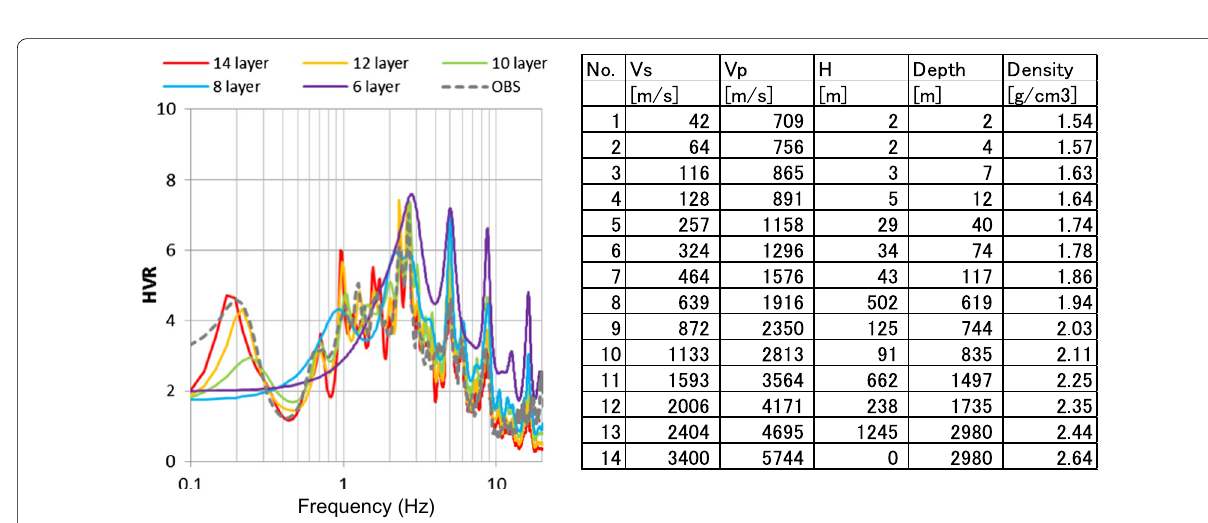
Fig. 7 A parametric study of the effect of the bottommost layer on the theoretical EHVR for the best-fit model at MYG006 with 14 layers (Nagashima et al. 2014, 2017). When we omit the two layers in one step from the original velocity model shown in the right, not only the amplitude of the lowest frequency peak but also the amplitudes of peaks and troughs in the higher frequency range are strongly